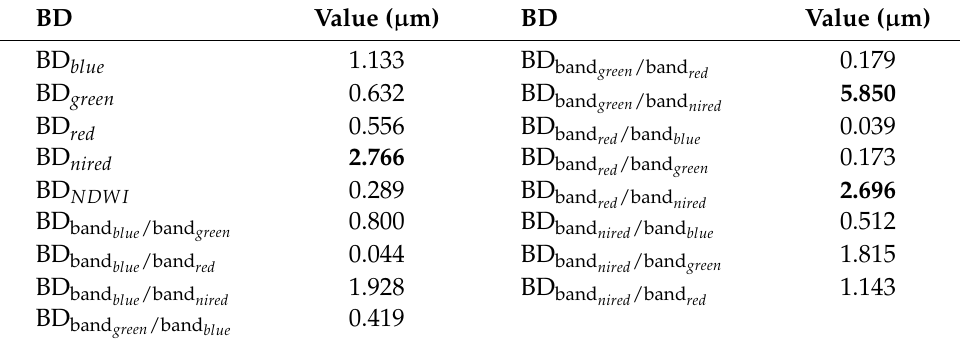
Table 1. The BD ratio of each